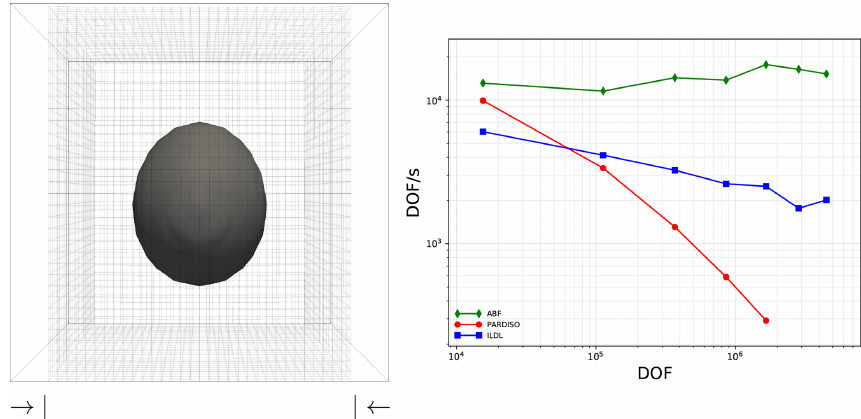
Figure 4. An experiment showing the performance of ILDL preconditioning for an elasticity problem with a heterogeneous medium in compression; the outer box shows the reference (undeformed) state, and the wire mesh shows the deformed state. The surrounding medium has a Poisson ratio of 1 / 3 ( λ = 2, µ = 1), and the originally spherical inclusion (radius 0 . 25) is almost incompressible, with a Poisson ratio greater than 0 . 4999 ( λ = 10 4 , µ = 1). Boundary conditions are free-slip everywhere except the top, which is stress free. The results show that ILDL preconditioning offers substantially better scaling performance (with a lower memory footprint) than a direct solver, without the auxiliary information, implementation, and tuning required for the even-better-scaling ABF solver. These experiments were run on a slightly different cluster than the preceding ones (see Sect. 5), so solve times are not directly